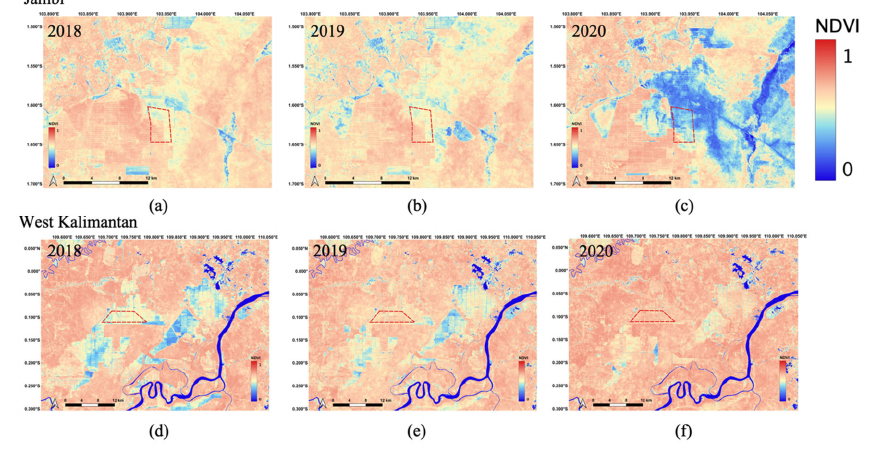
Figure 4. Yearly NDVI images for 2018, 2019, and 2020 in the study areas. ( a ) Jambi in 2018. ( b ) Jambi in 2019. ( c ) Jambi in 2020. ( d ) West Kalimantan in 2018. ( e ) West Kalimantan in 2019. ( f ) West Kalimantan in 2020.